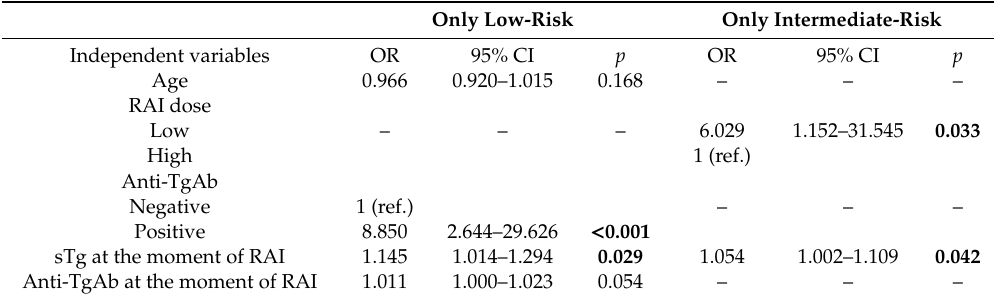
Table 4. Multivariate Logistic Regression Analysis—odds of nonexcellent response (separate analysis based on initial risk of recurrence).